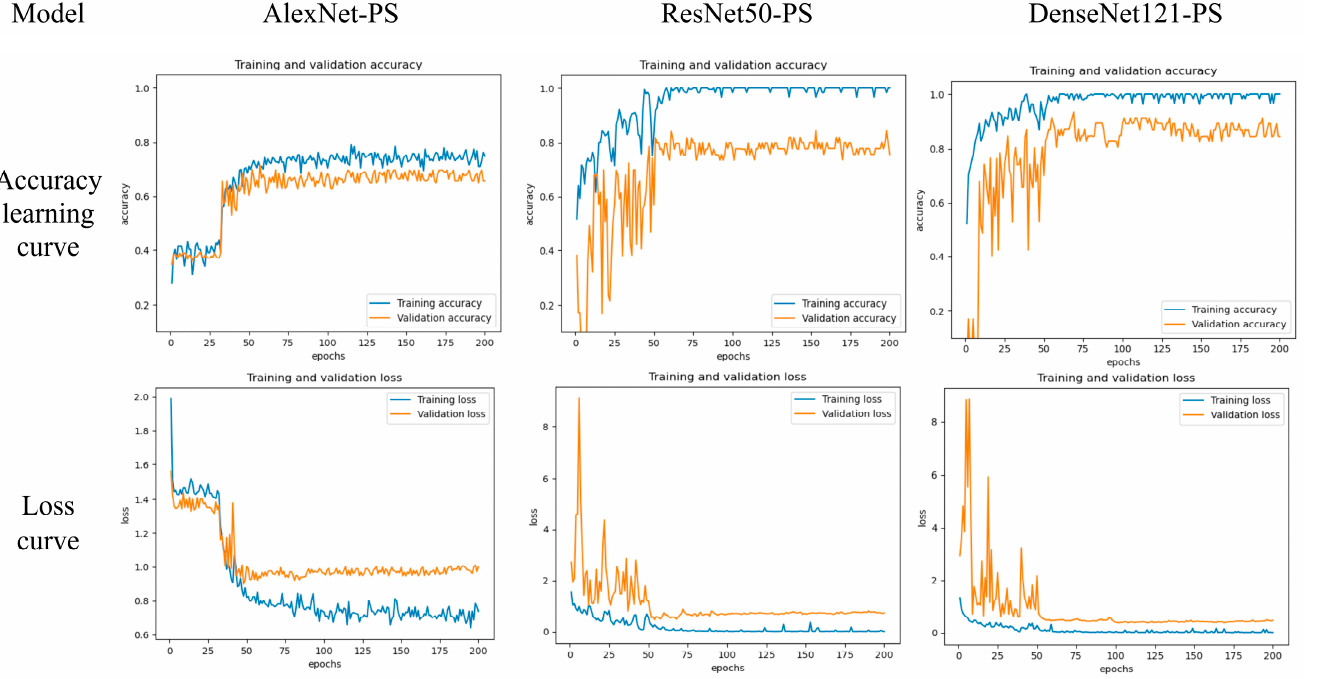
Figure 8. Accuracy and loss learning curve of tuned CNNs, includes AlexNet-PS, ResNet50-PS, and DenseNet121-PS.